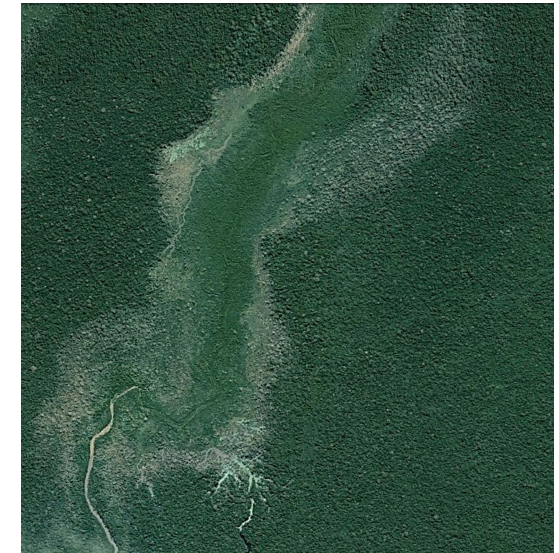
Figure 3. High-resolution image of forest die-off caused by a log- jam in 2009 along the Cuberene River in the Chimane Forest. The grayish areas show dead forest and land that has been covered with sediments. Note how the totality of the water is diverted towards the forest. Image from Google Earth ® . The river flows from southwest to northeast.